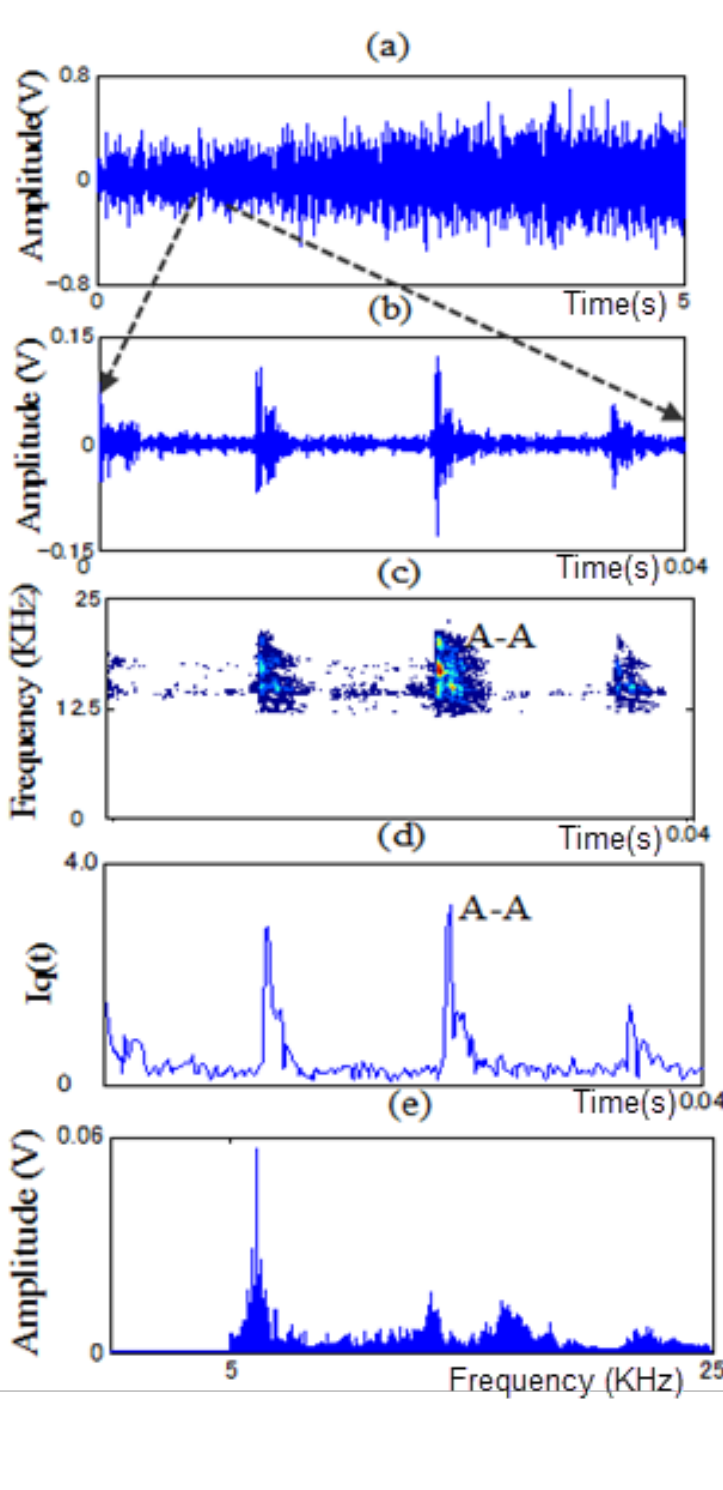
Figure 12. Contour graph and RCI of the spectra in the outer-race defect state: ( a ) time signal. ( b ) a part of time signal. ( c ) contour graph. ( d ) RCI and ( e ) power spectrum at position